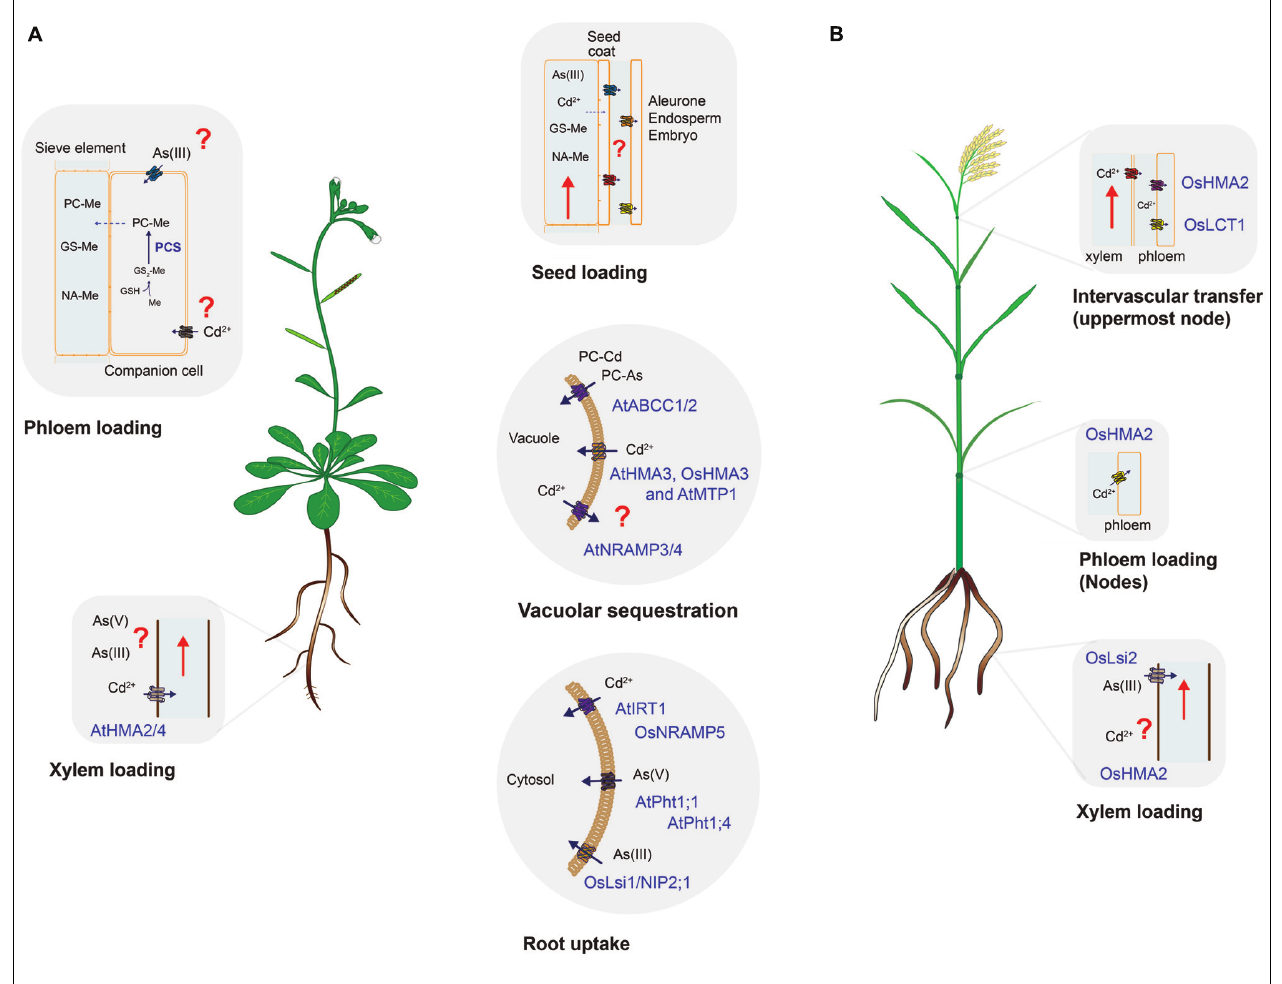
FIGURE 1 | Uptake and distribution of cadmium and arsenic in (A) Arabidopsis and (B) rice. Processes conserved in both species (root uptake, vacuolar sequestration, and seed loading) are shown in the middle panels. Species-specific transporters are denoted by At ( Arabidopsis ) or Os (rice). Processes where information is scarce, absent or that require further research are labeled with red question marks. The embryo and the maternal tissues (seed coat) are symplastically isolated, thus molecules have to be unloaded from the phloem to later